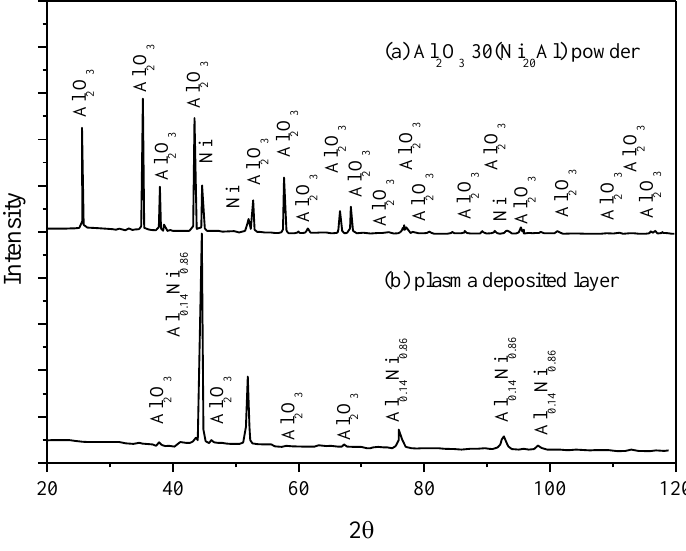
Figure 3. Comparative X-ray diffraction spectra of the Al 2 O 3 ·30(Ni 20 Al) powder and of the resulting plasma-deposited layer on the surface of the CuAl10Ni5Fe2.5Mn1 sample. ( a ) Diffraction spectrum for Al 2 O 3 30(Ni 20 Al) powder; ( b ) Diffraction spectrum for plasma deposited layer